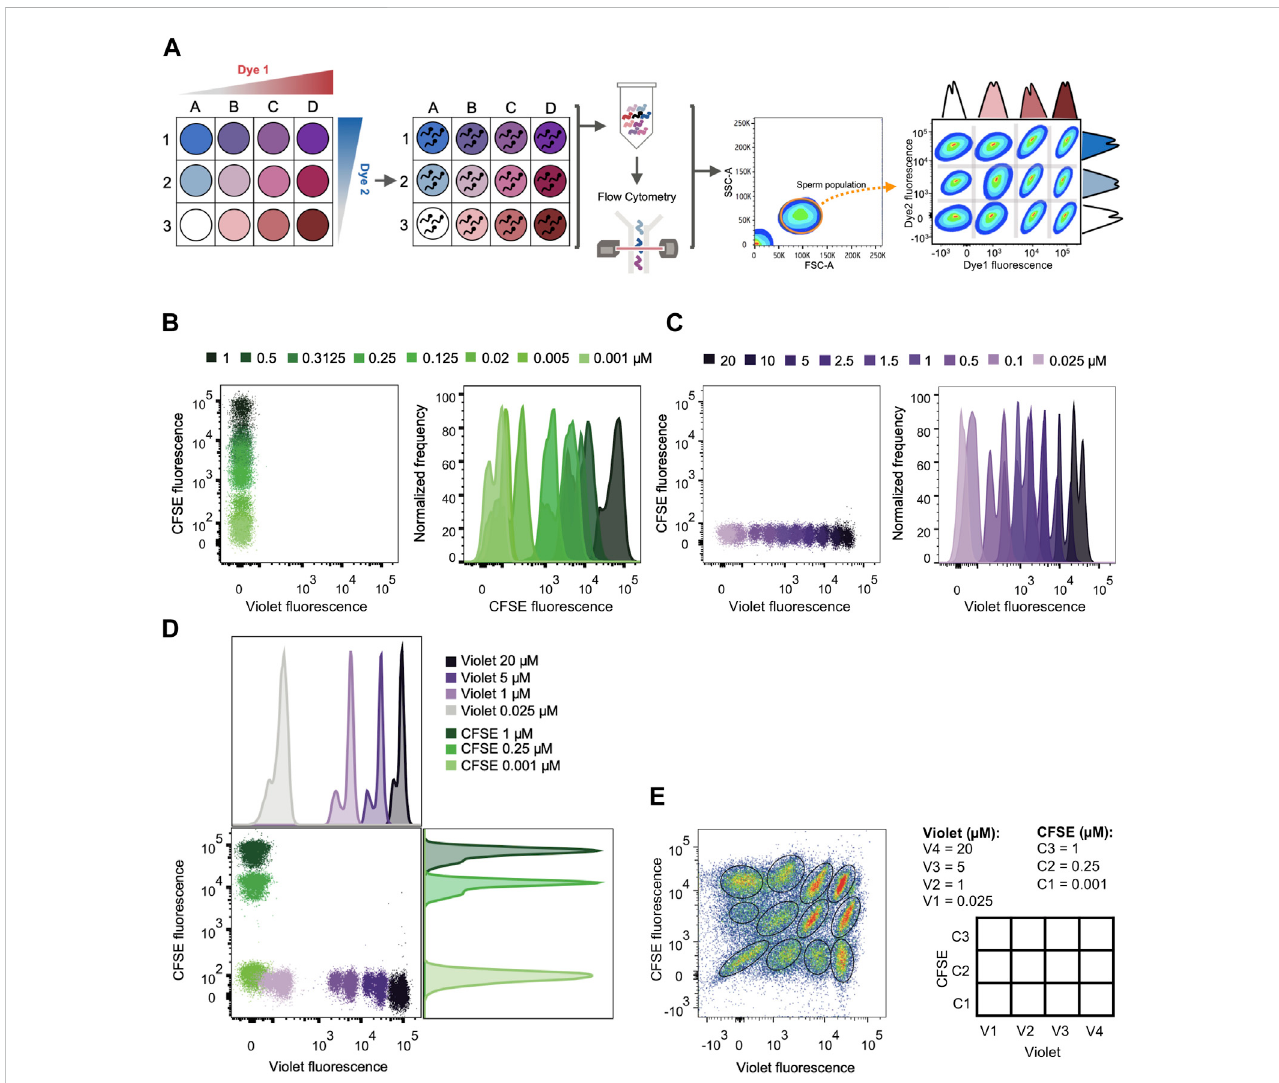
FCB set up in mouse sperm. (A) Schematicdiagram of the high-throughput screening method: First, each well is given one unique fl uorescent signature by the combination of dyes used in different concentrations. Second, sperm samples are distributed in the different wells and loaded with a distinct combinationof dyes. After loading, all samples are grouped in asingle tube and analyzed by fl ow cytometry. Following data acquisition, a sperm populationis selected from all the events. Each sperm sample is able to be distinguished through their corresponding dye fl uorescence signature. (B) Representative 2D dot plot of CellTrace ™ Violet vs. CellTrace ™ CFSE fl uorescence (left) and representative histograms of normalized frequency vs. CellTrace ™ CFSE fl uorescence (right). Sperm were incubated with increasing µM concentrations of CellTrace ™ CFSE and its fl uorescence raised in a dose dependent manner. (C) Representative 2D dot plot of CellTrace ™ Violet vs. CellTrace ™ CFSE fl uorescence (left) and representative histograms of normalized frequency vs. CellTrace ™ Violet fl uorescence (right). Sperm were incubated with increasing µM concentrations of CellTrace ™ Violet and its fl uorescence raised in a dose dependentmanner. (D) Representative2DdotplotofCellTrace ™ Violet(Dye1)vs.CellTrace ™ CFSE(Dye2) fl uorescence,withtheircorrespondinghistogram analysis depicting normalized frequency of sperm vs. dye fl uorescence. The concentrations selected for CellTrace ™ Violet and CellTrace ™ CFSE are shown, with no overlapping between each other. (E) Representative 2D dot plot of CellTrace ™ Violet vs. CellTrace ™ CFSE fl uorescence of a 4 × 3 matrix, where the population of sperm with each dye combination/signature was de fi ned. The diagram with the dye concentration in each well is depicted on the right as a double-entry